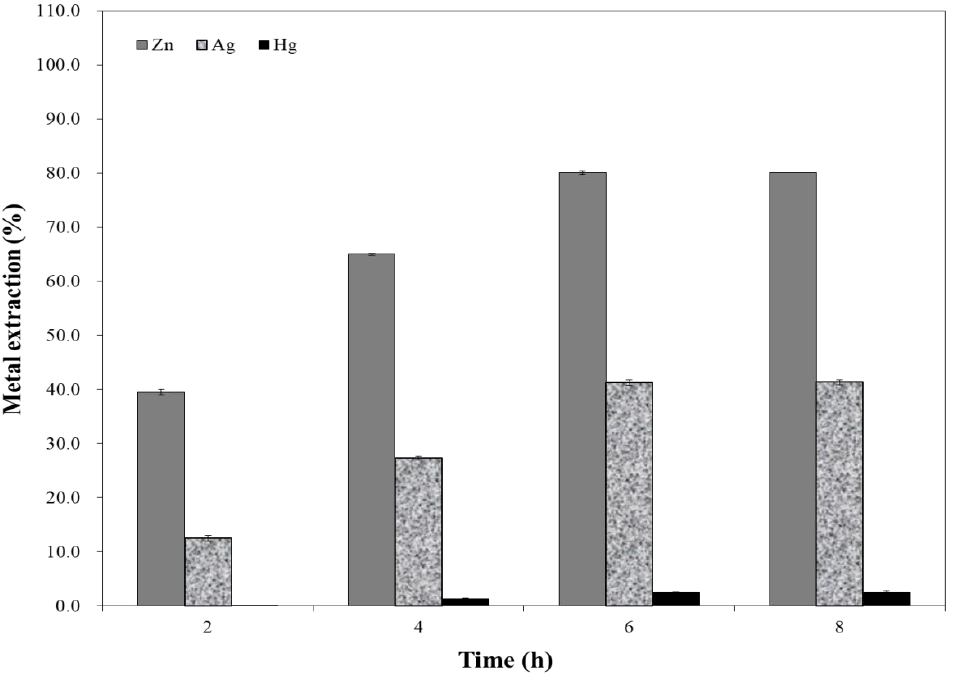
Figure 1. Evaluation of time period for leaching of metals using 100 mL A. niger spent medium at 30 °C and 150 rpm.